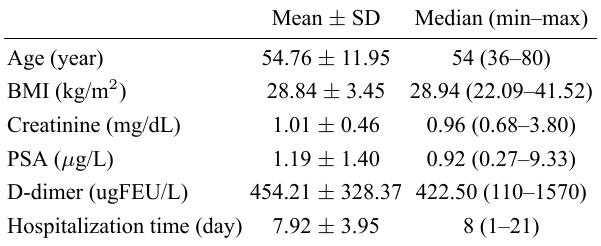
Table 1. Descriptive analysis of study